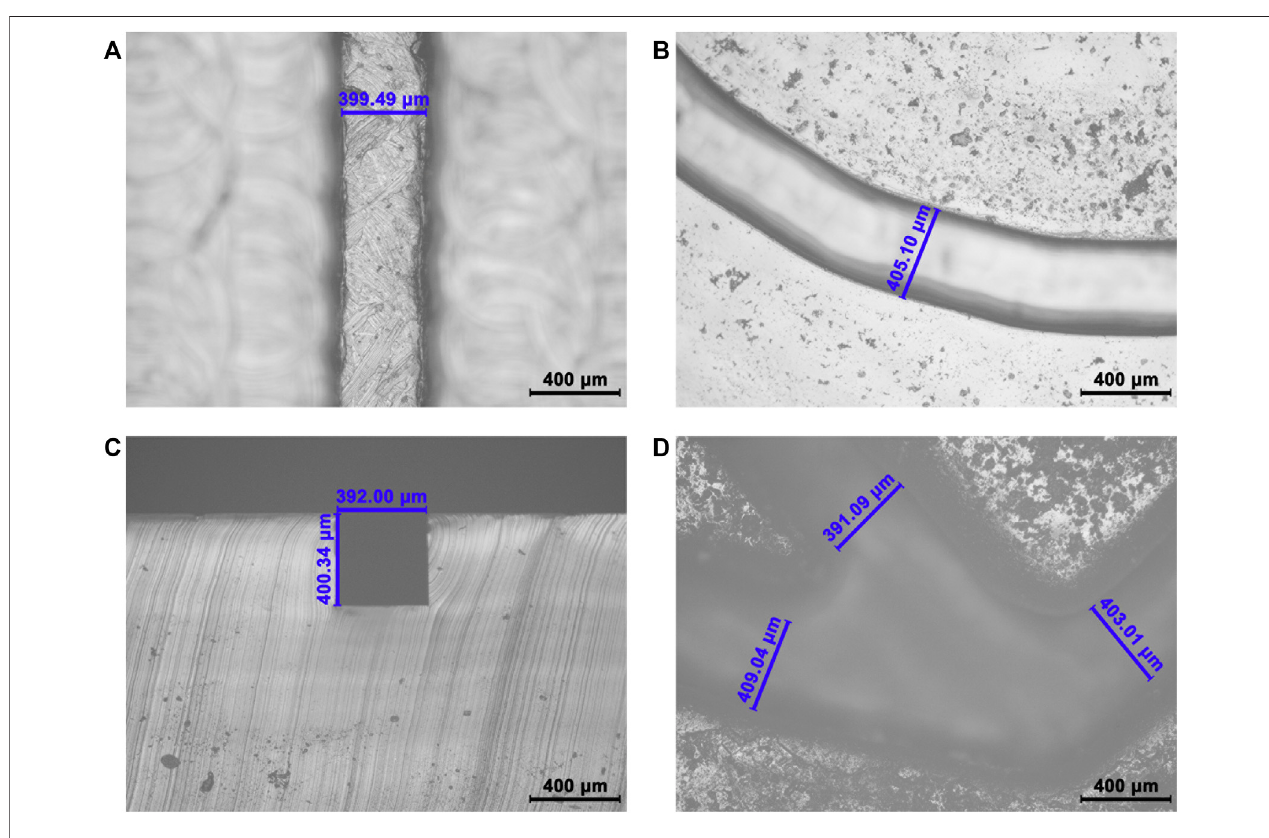
FIGURE3| Schematicdiagram ofdetecting samplesinSMC. (A) PretreatmentofSMCincluding capture antibodycoating, surfaceblocking, and reagentloading. (B) SamplesanddetectionantibodiesaremixedandreactedinanArchimedeanspiralchannel. (C) Speci fi cimmunoreactionhappensintheS-shapedmicrochannel. (D) Washing the unreacted reagent. (E) Chemiluminescent substrates are added to produce chemiluminescent signals. (F) Schematic diagram of the PM valve.